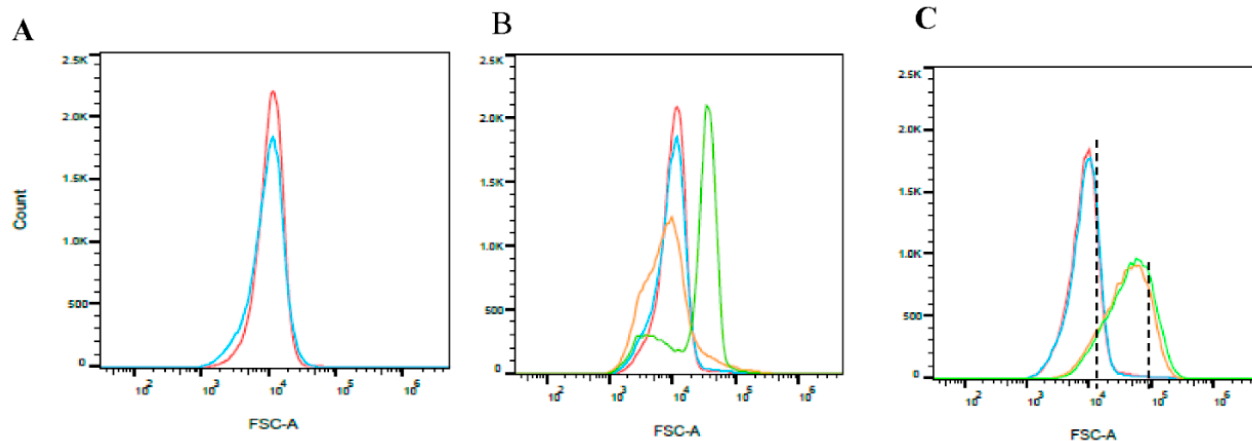
Figure 5. FCM (flow cytometry) analysis of S. aureus relative cell size. ( A – C ) represent comparison between the PEF-treated and nontreated samples at selected times: ( A )—‘0’ time; ( B )—1.5 h; ( C )—24 h. Nontreated cells in PBS-red; nontreated cells in BHI-orange; PEF-treated cells in BHI-green; PEF-treated cells in PBS-blue.